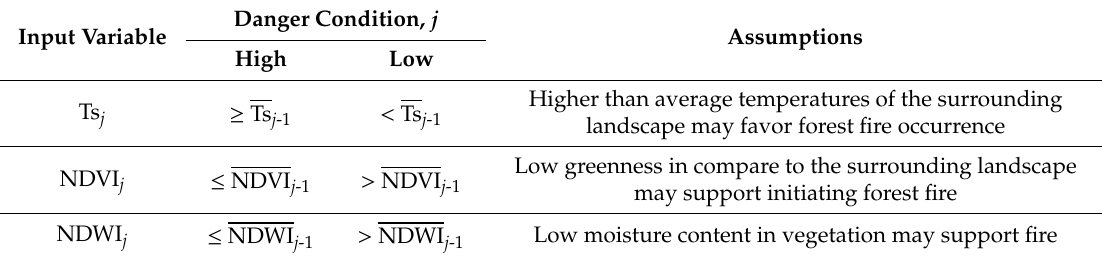
Table 2. Assumptions of the fire danger conditions that were considered in the model for forecasting the next four days for each pixel in each variable.